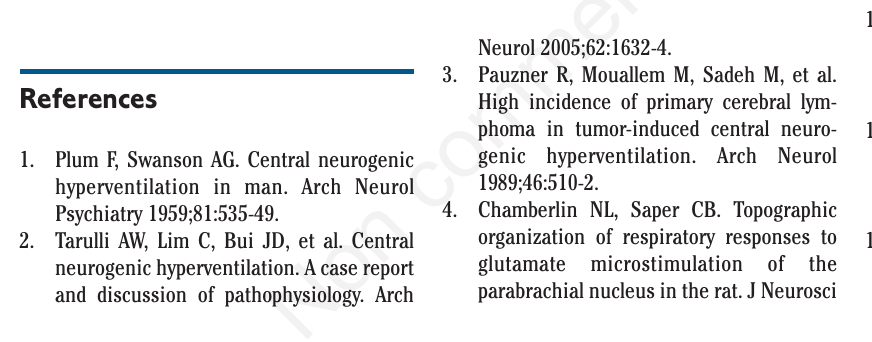
Figure 2. T2-weighted and diffusion weighted images show no pathologic intensity on